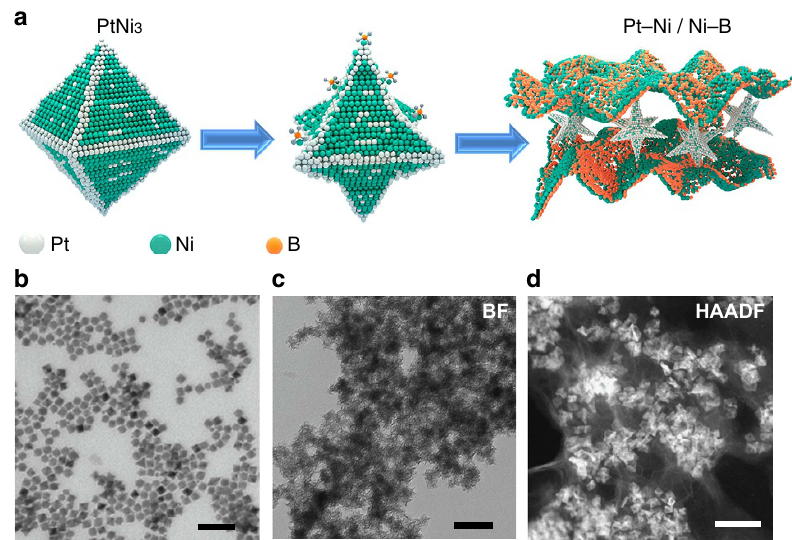
Figure 1 | Scheme and TEM images of Ni–B membrane growing process. ( a ) Scheme illustrating the structural transformation from PtNi 3 octahedron to Pt-Ni/Ni–B composite. TEM images of ( b ) initial PtNi 3 octahedrons and ( c ) Pt-Ni/Ni–B composite. ( d ) High-angle annular dark-field scanning transmission electron microscope (HAADF-STEM) image of Pt-Ni/Ni–B composite. Scale bars, 50nm.